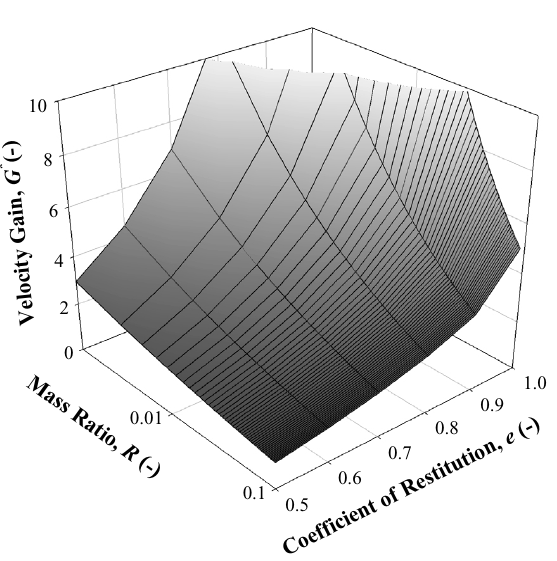
Fig. 9. Plot of G ∗ versus R and e , for the MVG system of vertically-stacked masses. (-) means non-dimensional. The nearest rounded integer (both floor and ceiling) to n ∗ that yields a higher value of G n through Eq. (24) is then n max and the corresponding G n is G max